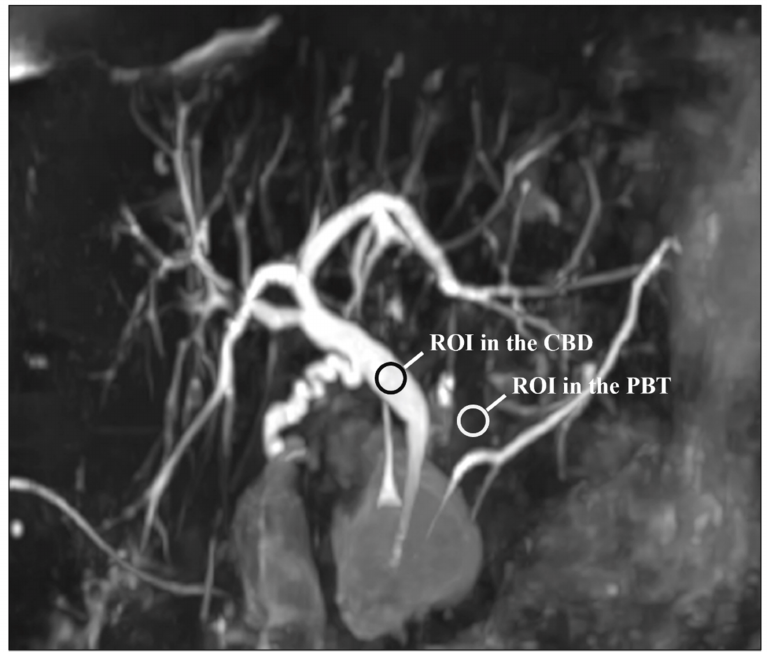
Figure 1. Representative section of the common bile duct (CBD) used for the quantitative evaluation of image quality: note the regions of interest (ROIs) on the CBD and peri-biliary tissues (PBT). Note that the ROIs were drawn on the native images and not on the MIP reconstruction as shown